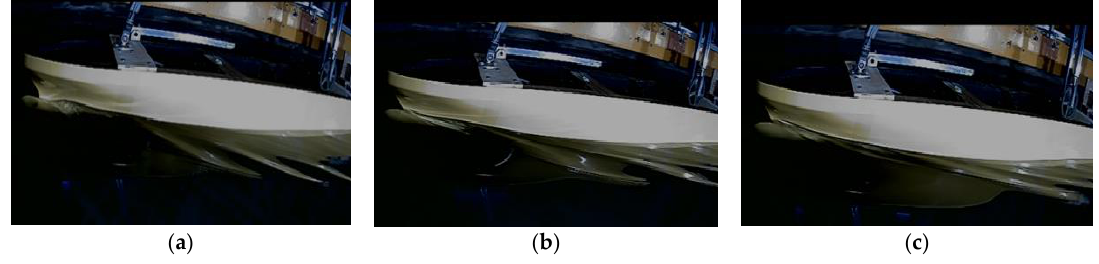
Figure 5. Calm water resistance: ( a ) 𝐹 𝑅 = 0.131; ( b ) 𝐹 𝑅 = 0.174; ( c ) 𝐹 𝑅 = 0.218.